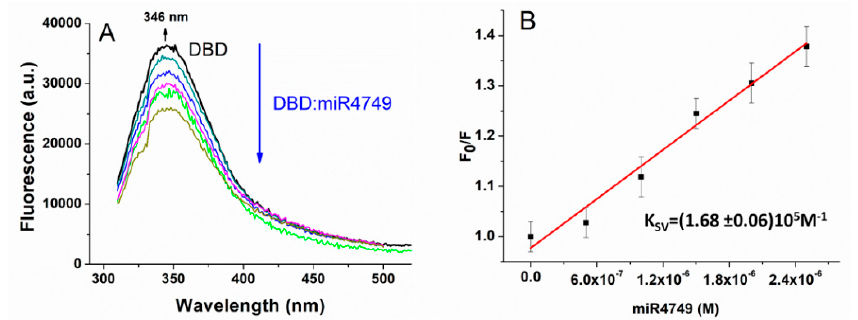
Figure 2. ( A ) Fluorescence emission spectra of DBD (1 µ M) alone (black line) and at progressively higher concentrations of miR4749 (0.5-2.5 µ M; colored lines) at 298 ◦ K, by exciting at 295 nm and corrected for the Raman scattering of the bu ff er. ( B ) Stern–Volmer plot of the fluorescence quenching of DBD (1 µ M in PBS bu ff er) as a function of miR4749 concentration at 298 ◦ K, shown as black squares. Continuous red line is the linear fit through Equation (1); the extracted Stern–Volmer constant, K SV , being reported.